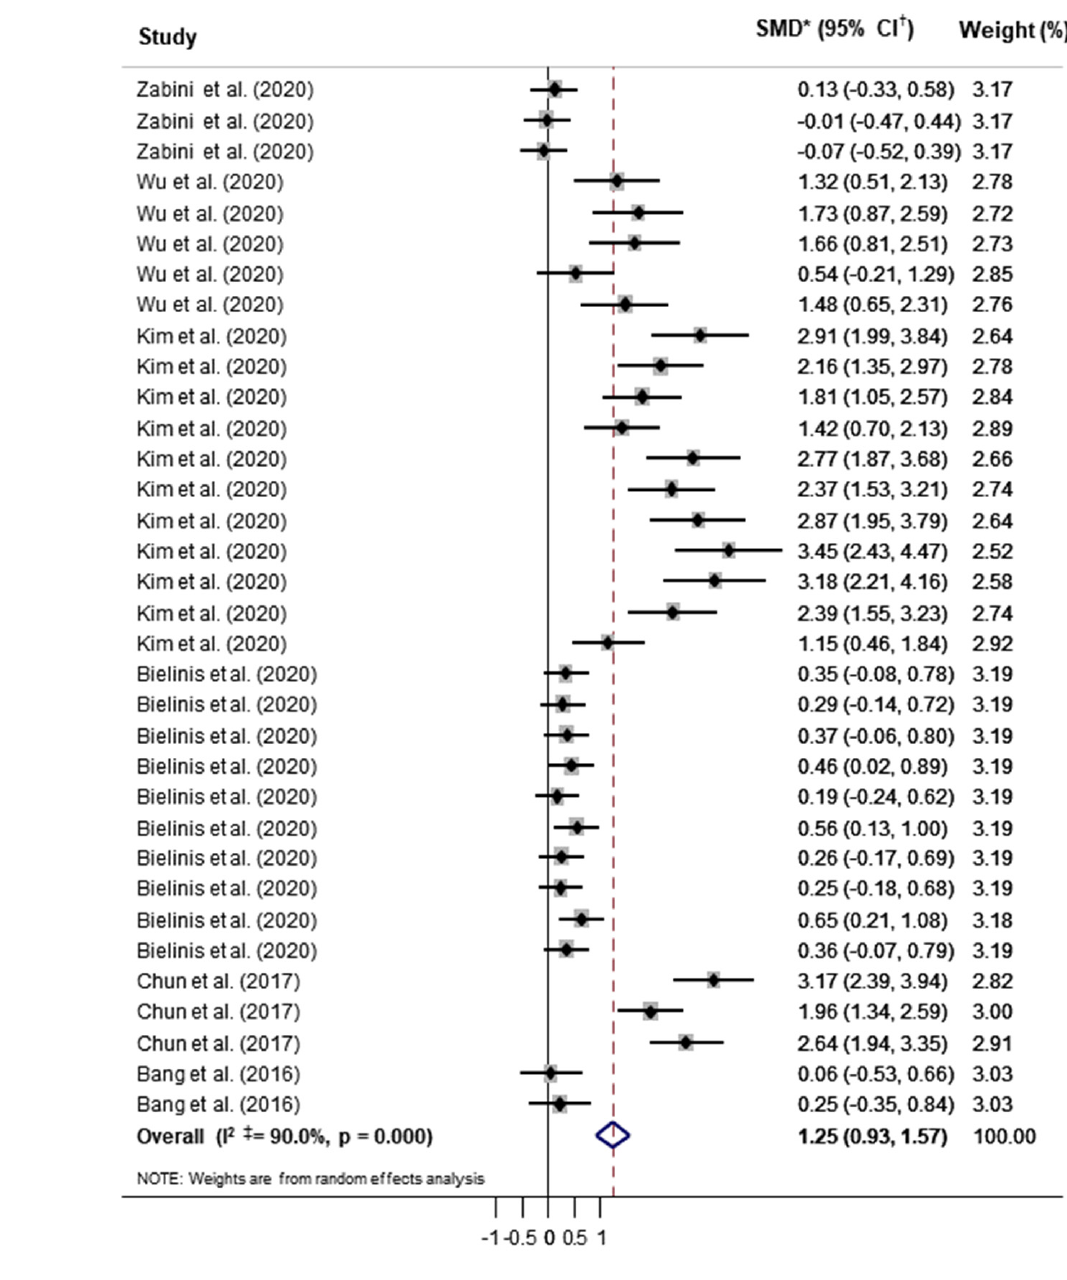
Figure 2. Effects of forest-based interventions on mental health.